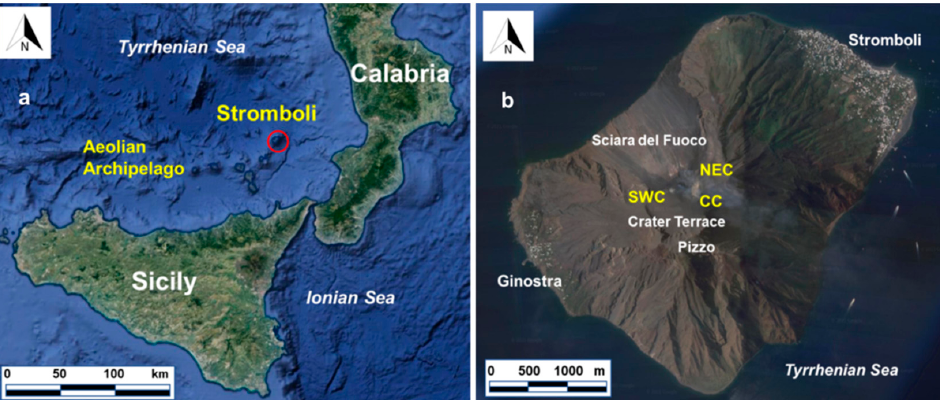
Figure 1. (a) Google map of southern Italy, with the red circle showing the position of Stromboli volcano, at the NE end of the Aeolian Archipelago. (b) Stromboli Island with the position of active craters. NEC = NE Crater zone; CC = Central Crater zone; SWC = SW Crater zone, all of them located within the summit Crater Terrace located at ~750 m above sea level. Sciara del Fuoco is a horseshoe-shaped depression formed by several landslides in the NW sector of the volcano, which is 1700 m wide, and extends underwater to a depth over 2000 m.